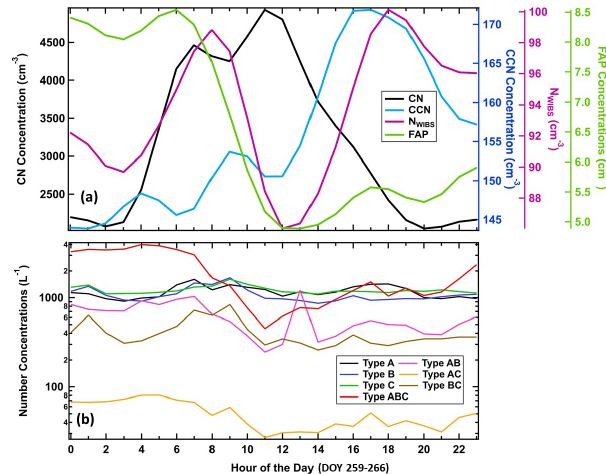
Figure 3. (a) Hourly concentrations of CN (black curve) and CCN at 0.3% supersaturation (solid blue curve), N WIBS (magenta) and FAP (green) concentrations. (b) Hourly concentrations of the seven types of